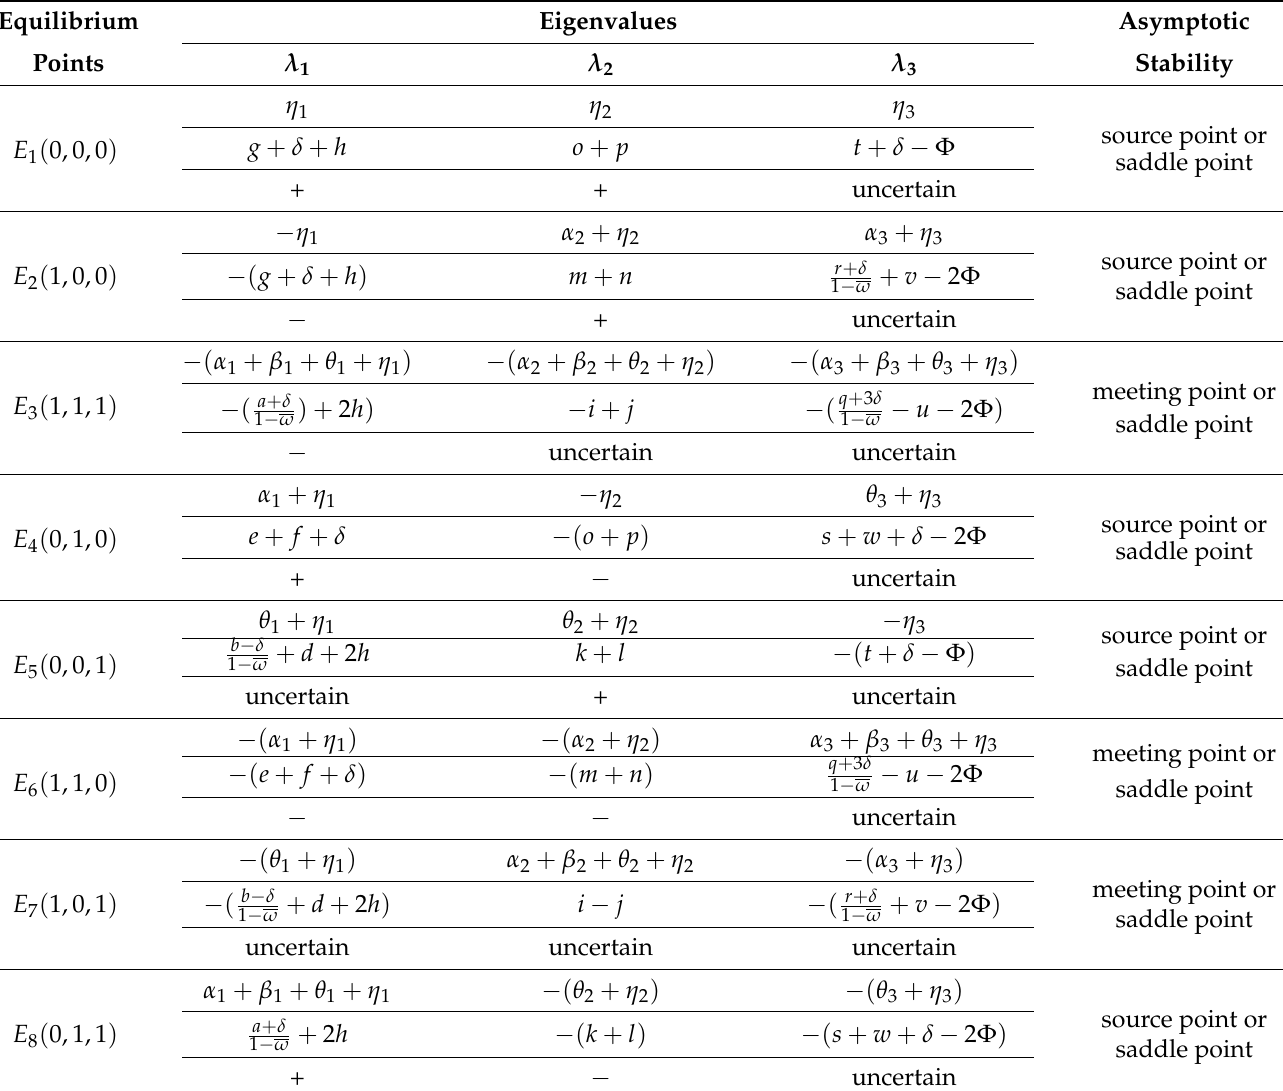
Table 4. Stability of equilibrium points.